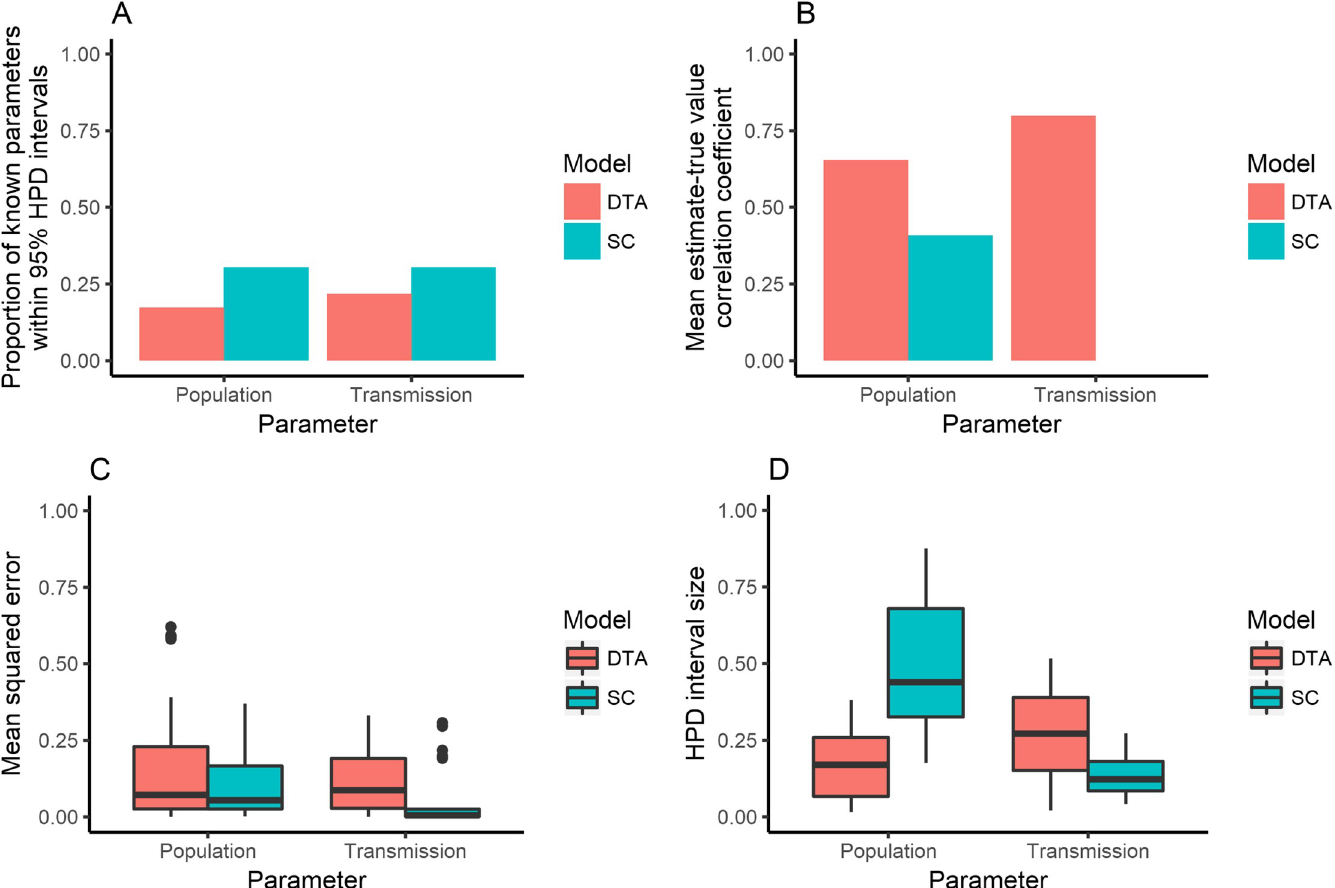
Fig 9. The proportion of outbreak simulations that the models included the known parameter within their 95% highest posterior density (HPD) intervals (A); the correlation coefficient between known parameters and the models’ mean estimates (B); the mean squared errors between known parameters and the models’ mean estimates (C), and the size of the models’ 95% HPD intervals (D), for the population and transmission estimates made by the DTA (red) and SC (blue) models for 23 simulated outbreaks that 100 isolates were sampled equally over time from.